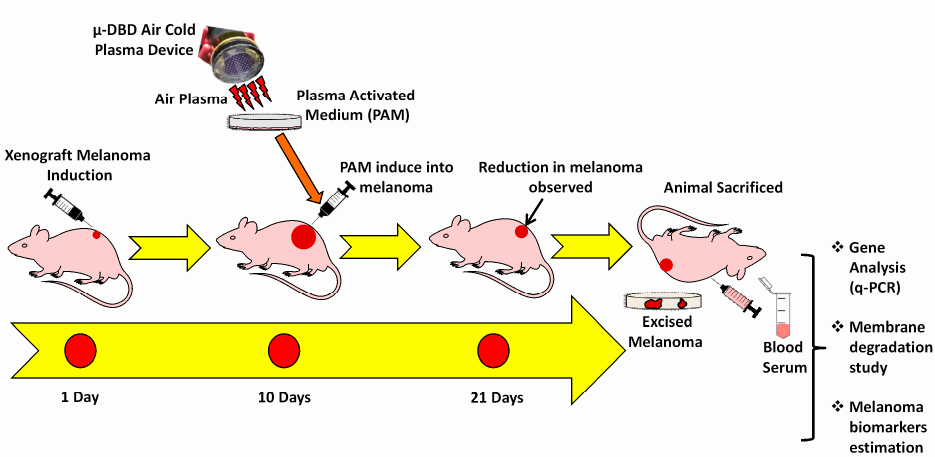
Figure 1. Schematic representation of human melanoma xenograft induction (G-361) and treatment strategies by cold atmospheric plasma (CAP) activated medium (Plasma-Activated Media (PAM)) in nude mice. Melanoma and blood were extracted from the mice on the 21st day for further experiments.